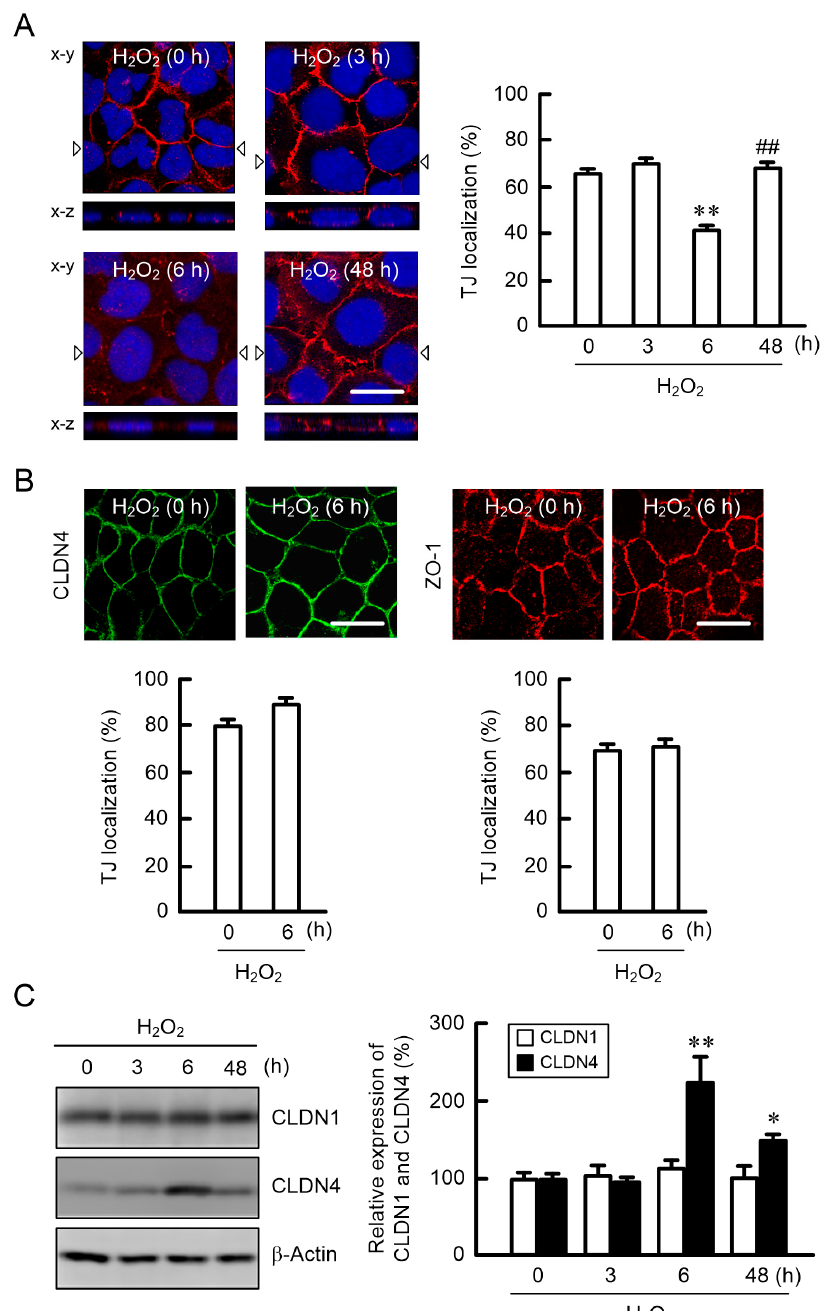
Figure 2. Effects of H 2 O 2 on the localization and expression of claudins (CLDNs). Cells exposed to 200 μ M H 2 O 2 were cultured for 0, 3, 6, and 48 h. ( A ) The cells were immunostained with anti-CLDN1 (red) antibodies and DAPI (nuclear marker). The low panels (x-z) show the vertical sections indicated by the triangles of x-y images. Scale bars indicate 10 μ m. The fluorescence values of CLDN1 at the tight junction (TJ) are shown as a percentage of the total fluorescence values. ( B ) The cells were immunostained with anti-CLDN4 (green) or anti-ZO-1 (red) antibodies. The fluorescence values of CLDN4 and ZO-1 at the TJ are shown as a percentage of the total fluorescence values. ( C ) Cell lysates were applied to 12.5% SDS-PAGE and blotted with anti-CLDN1, anti-CLDN4, and β -actin antibodies. The expression levels of CLDN1 and CLDN4 are represented relative to the values at 0 h. n = 3–8; ** p < 0.01 and * p < 0.05 significantly different from 0 h; ## p < 0.01 significantly different from 6 h.